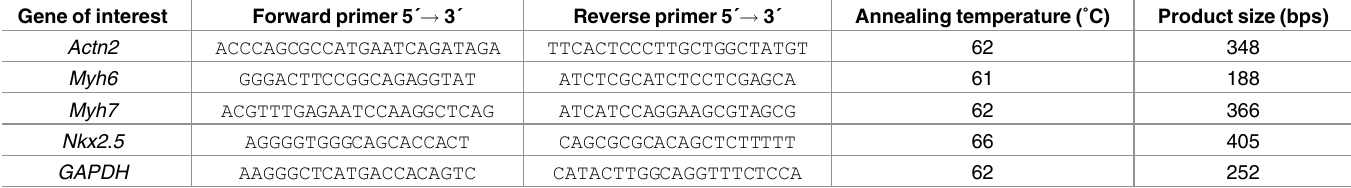
Table 1. Sequence of primers used in quantitative RT-PCR.